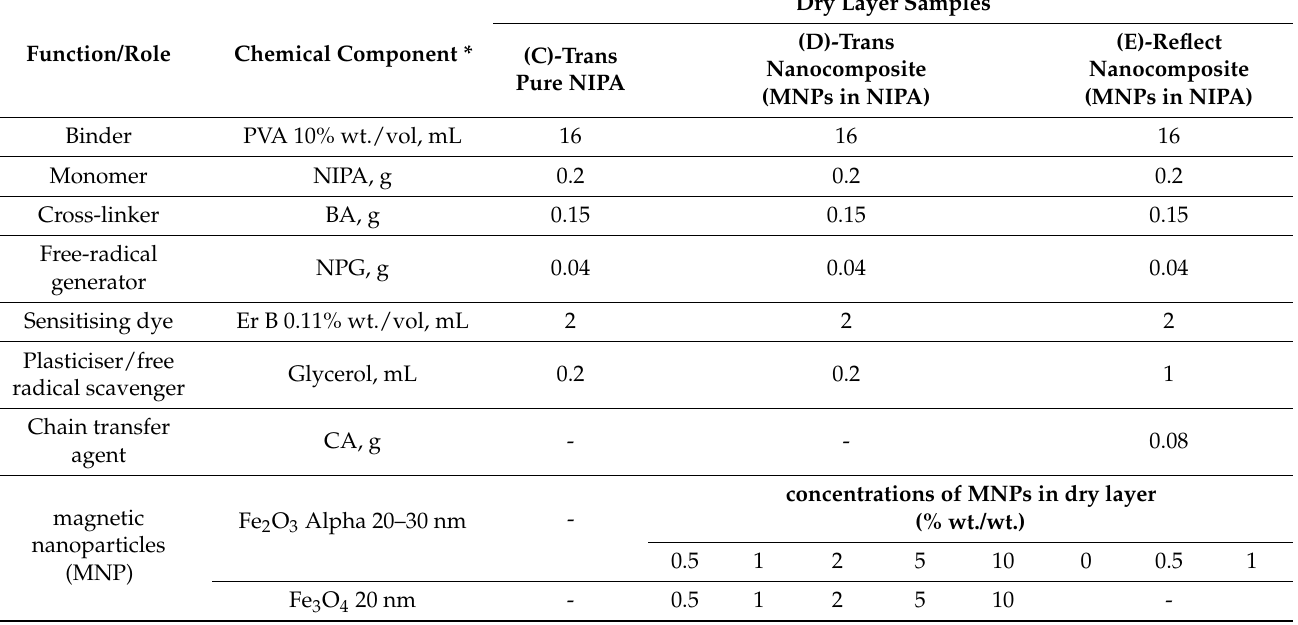
Table 2. Composition of dry layer samples (C, D, E). The dry layer samples, (C)-pure